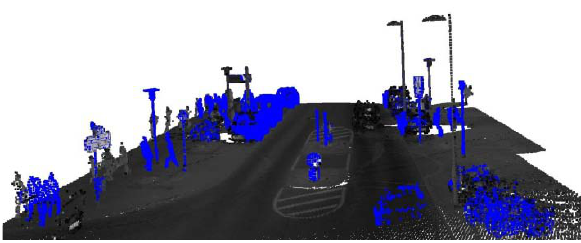
Figure 5: Segments of one point cloud (blue) are compared to points of another point cloud (colored by intensity values).